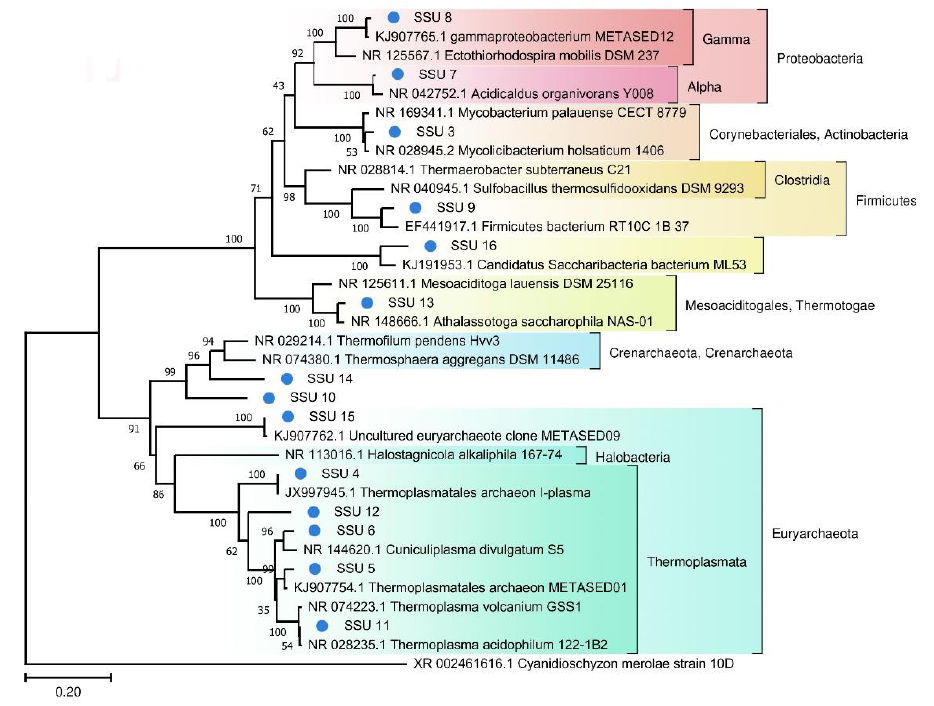
Figure 4. The phylogenetic tree of the prokaryotic SSU sequences from FAU and their closest homologs (The Tamura–Nei substitution model with the gamma distribution (TN93 + G)).